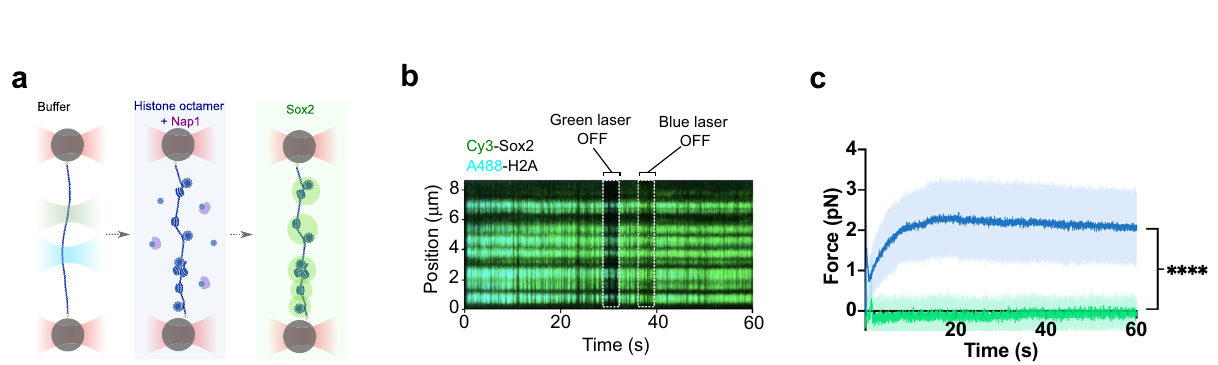
Fig. 4 Nucleosomes colocalize with Sox2 condensates and attenuate their mechanical effects on DNA. a (Left) Schematic of double-tethered λ DNA loaded with nucleosomes. (Right) Time-averaged projections of three double-tethered nucleosomal DNA molecules with different end-to-end distances (among 5 independent experiments). Nucleosomes were visualized by Cy3-labeled histone H2B. Scale bar, 0.5 μ m. b Schematic and time- averaged projections of the same three nucleosomal DNA molecules as in a when incubated with 10 nM Cy5-labeled Sox2. Scale bar, 0.5 μ m. c Real- time tracking of Cy5-Sox2 intensities at a nucleosome position (circled region) on a double-tethered nucleosomal λ DNA. Scale bar, 0.5 μ m. d , Corresponding Cy3-H2B intensities within the same circled region as in c . Scale bar, 0.5 μ m. e (Left) Snapshot of a double-tethered DNA harboring Cy3-H2B nucleosomes and Cy5-Sox2 condensates. (Right) Intensity pro fi les of Cy3-H2B (green) and Cy5-Sox2 (red) along the length of the same DNA molecule. R value represents Pearson ’ s correlation coef fi cient. Scale bar, 0.5 μ m. f Pearson ’ s correlation coef fi cients averaged from all aligned Cy3-H2B and Cy5-Sox2 intensity pro fi les and from Costes ’ randomized control ( n = 158). Error bars denote 95% CI. Signi fi cance was obtained using an unpaired two-sample t test (**** P < 0.0001). g Fraction of double-tethered bare DNA ( n = 379) versus nucleosomal DNA molecules ( n = 303) that broke after 15 min of incubation with 10 nM Sox2. Data are averaged from at least three fi elds of view. Error bars denote standard deviation. Signi fi cance was obtained using an unpaired two-sample t test (**** P < 0.0001). h Schematic and time-averaged projection of a single-tethered nucleosomal λ DNA visualized by Cy3-H2B fl uorescence. Scale bar, 0.5 μ m. i Schematic and time-averaged projection of the same nucleosomal DNA molecule as in h when incubated with 10 nM Cy5-Sox2. Scale bar, 0.5 μ m. j Average fl uctuation radius of single-tethered nucleosomal λ DNA in the absence or presence of Sox2 ( n = 42). Error bars denote 95% CI. Signi fi cance was obtained using an unpaired two-sample t test (ns, P = 0.28). Source data are provided as Source Data Fig. 4.